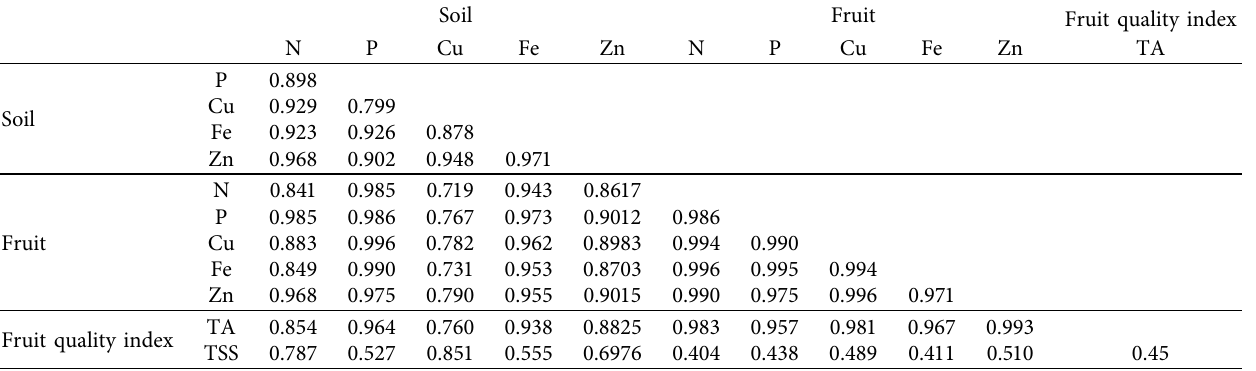
Table 4: Correlation among different mineral nutrients of soil and fruit of quince. Soil Fruit Fruit quality